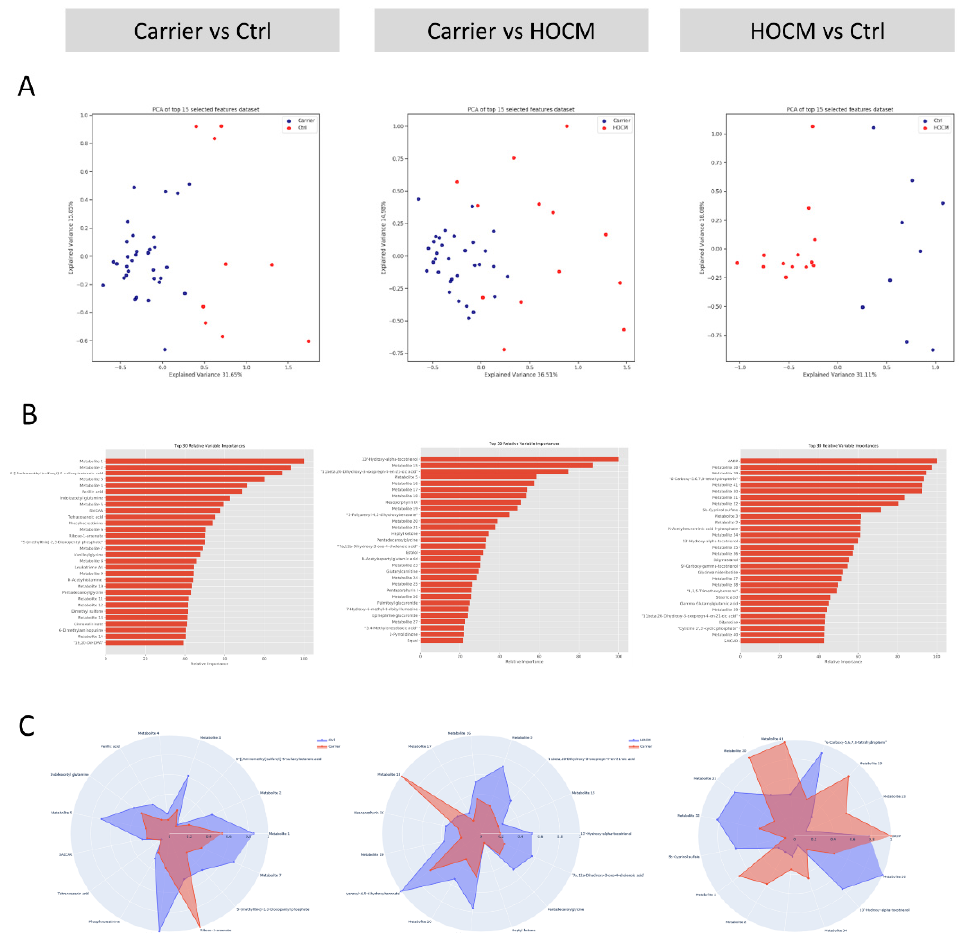
Figure 2. Multivariate modeling. ( A ) Principal component analysis (PCA) for the three group-wise comparisons: Carrier vs. Ctrls, Carrier vs. HOCM patients and HOCM patients vs. Ctrls. ( B ) Top 30 most predictive metabolites sorted based on their relative importance in distinguishing the two groups. ( C ) Radar plots of the top 15 most predictive metabolites, illustrating the differences in the serum metabolite profiles between the